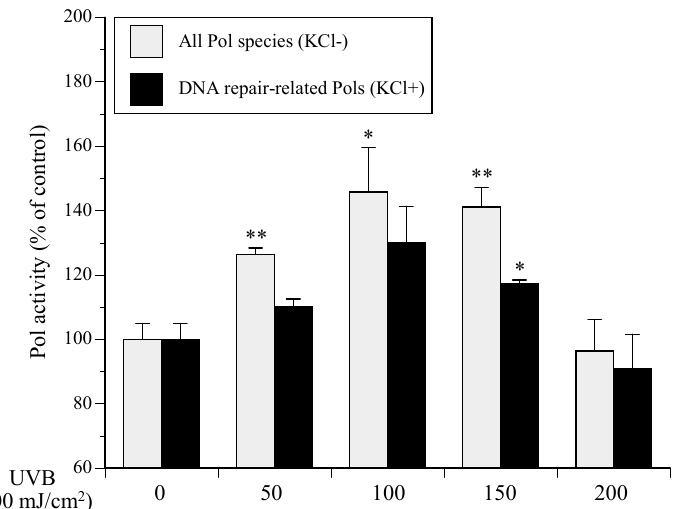
Figure 1. Cellular polymerase (Pol) activity in ultraviolet B (UVB) ‐ exposed normal human epidermal keratinocytes (NHEKs) is dependent on UVB irradiation levels (50–200 mJ/cm 2 ). After UVB irradiation, NHEKs were cultured for 4 h. Gray bars represent human whole Pol (standard reaction conditions without 120 mM KCl) and black bars represent DNA repair ‐ related Pol species (with 120 mM KCl), respectively. Pol activity of vehicle control without UVB irradiation was arbitrarily designated 100%. All data are the mean ± SEM ( n = 3). * p < 0.05 and ** p < 0.01 compared with the UVB ( − ) vehicle control.